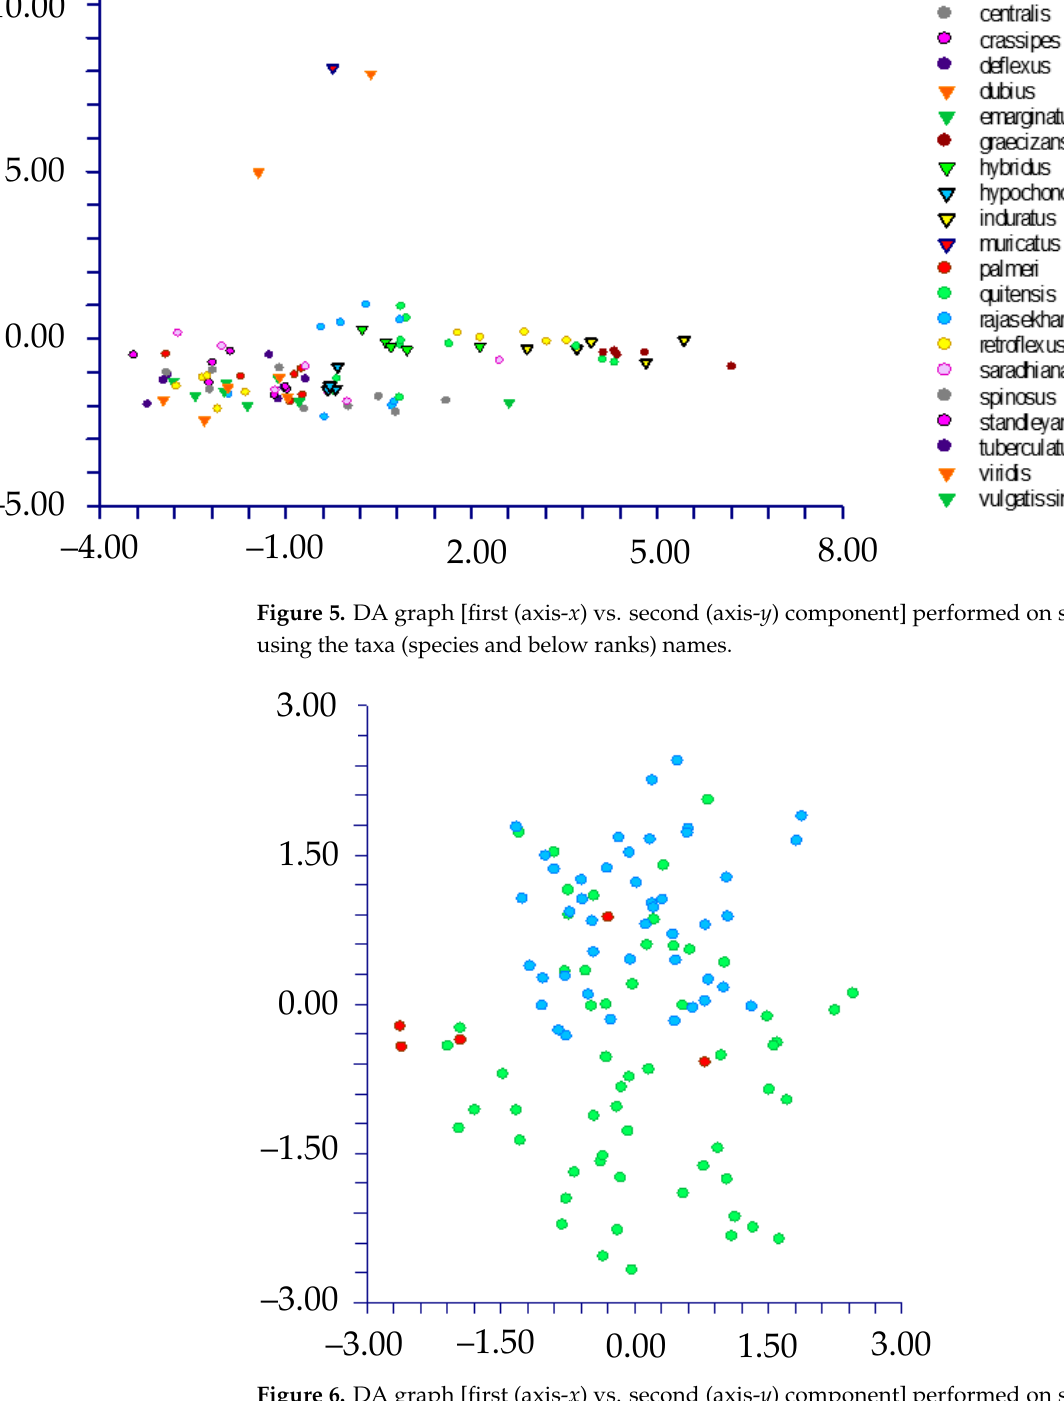
Figure 6. DA graph [first (axis- x ) vs. second (axis- y ) component] performed on samples classified using the subgenera names (blue dots: subgen. Amaranthus; red dots: subgen. Acnida; green dots: subgen. Albersia).